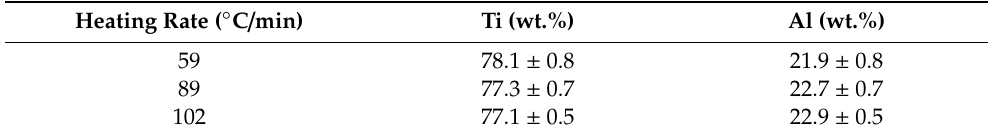
Figure 3. The XRD patterns of TiAl63 alloys obtained by various heating rates in the induction furnace.